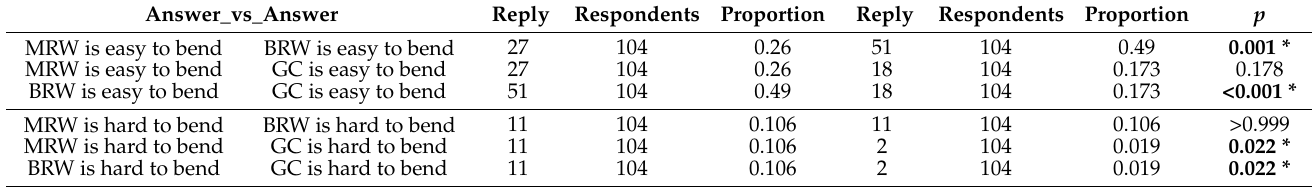
Table 2. Bending characteristics of the wires according to the